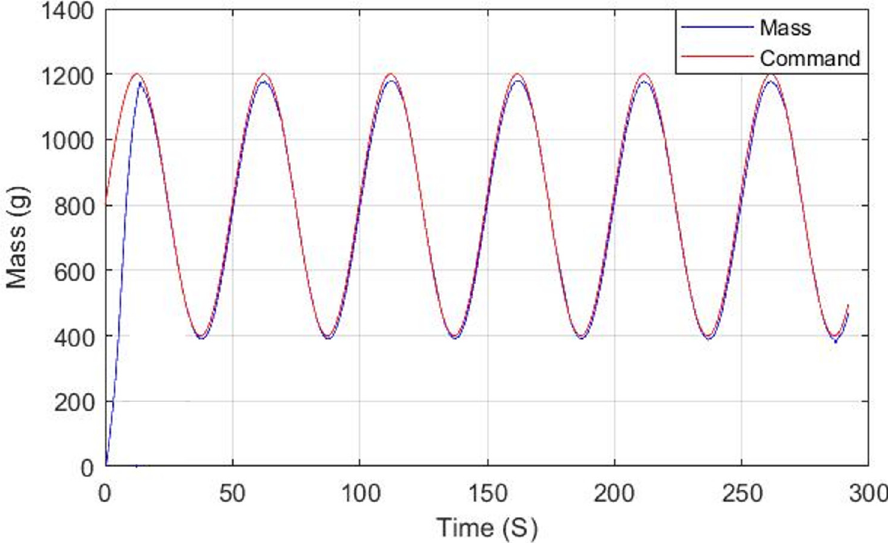
Figure 12. Closed-loop force control of a sine command signal.